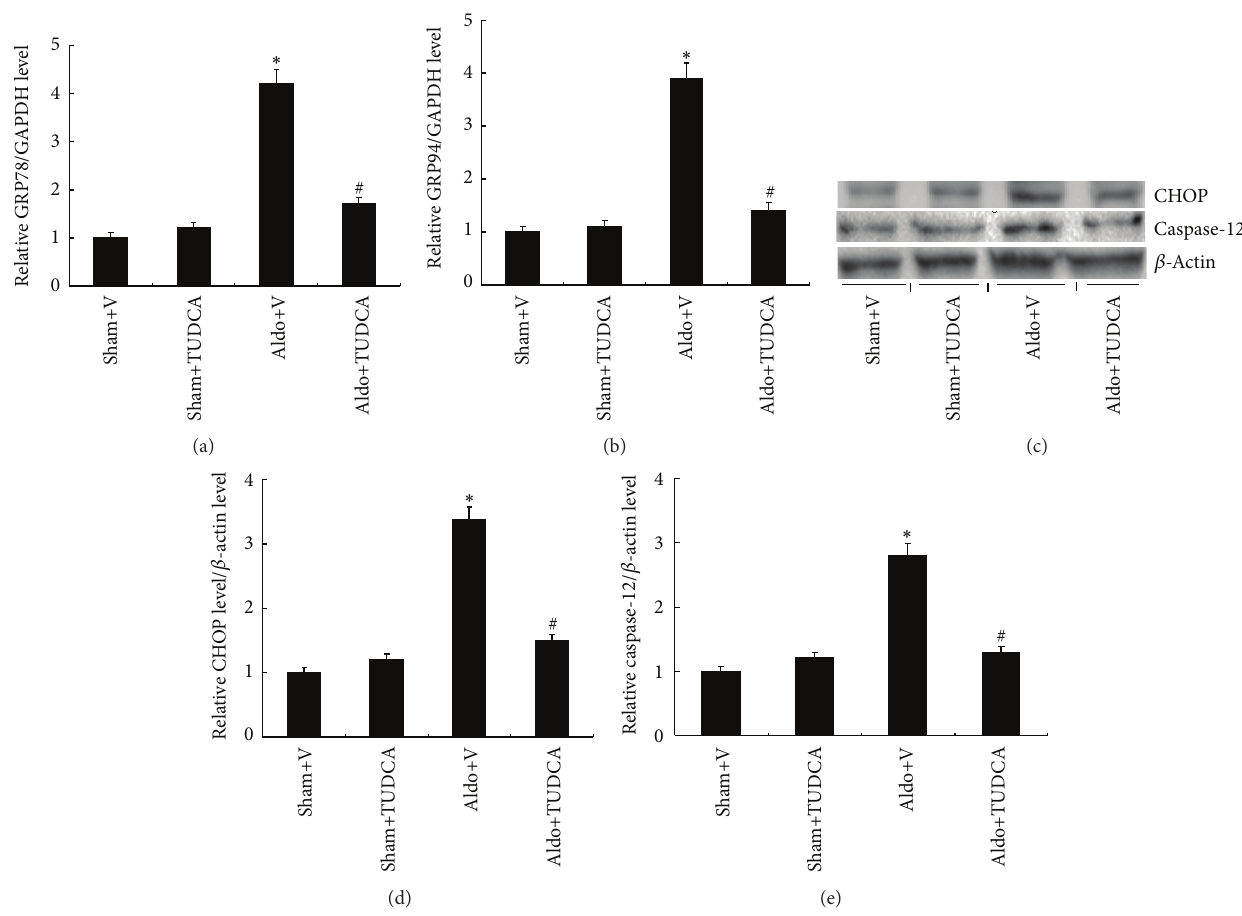
Figure 4: TUDCA ameliorated Aldo-induced ER stress. (a) Relative mRNA expression of GRP78 compared to expression of GAPDH. (b) mRNA expression of GRP94 relative to the expression of GAPDH. (c) Representative Western blots of CHOP and caspase-12. (d) Relative expression of CHOP to expression of 𝛽 -actin. (e) Relative expression of caspase-12 to expression of 𝛽 -actin. Values are mean ± SEM ( 𝑛 = 6 ). ∗ 𝑝 < 0.05 , Sham+V group versus Aldo+V group, # 𝑝 < 0.05 , Aldo+V group versus Aldo+TUDCA